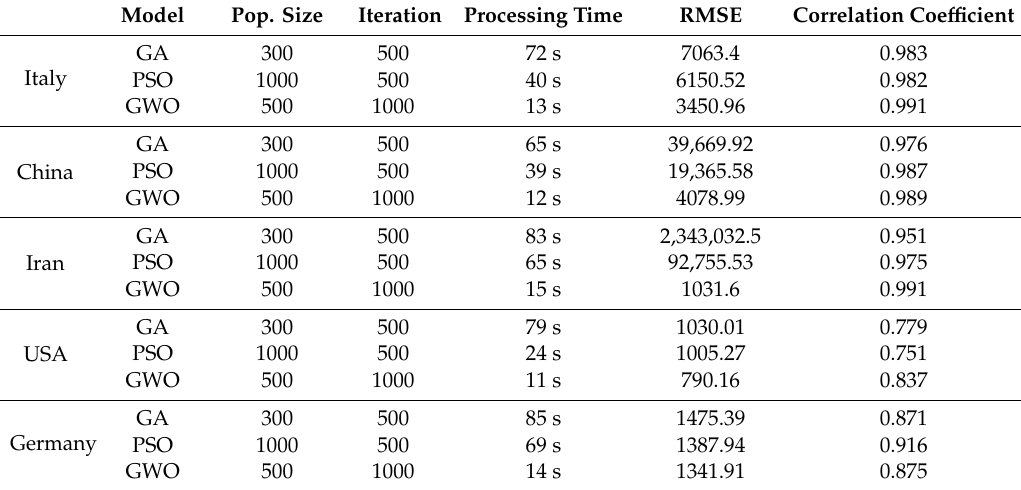
Table 9. Accuracy statistics for the power model.